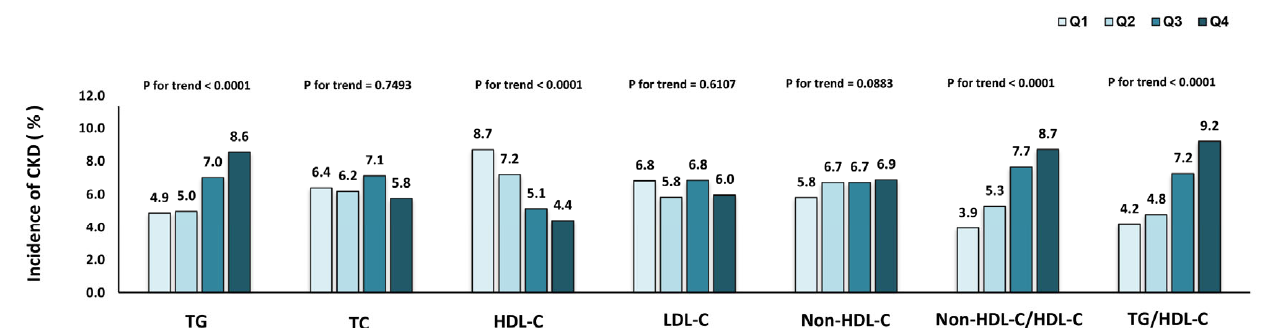
Figure 2. Incidence of chronic kidney disease in different quartiles of baseline lipid parameters. Across all Cox regression models, TG/HDL‑C showed the highest association with Table 3. Association between baseline lipid parameters and risk of CKD. CKD in comparison to other lipid parameters (Table 3). Additionally, among all AUC values, TG/HDL‑C was highest (0.599, 95% CI: 0.568–0.630). To validate the robustness of this outcome, we carried out a stratified analysis to determine the HRs of CKD per quartile gain in TG/HDL‑C in distinct subgroups. Such an association varied under the influence of different stratification factors, as shown in Figure 3. The link between TG/HDL‑C and CKD incidence was meaningful in both age strata ( ≥ 58 and <58), in the female strata, in the BMI strata (normal and overweight), in both central obesity strata, in the subjects without diabetes stratum and in the subjects without hypertension stratum. The interaction term for the correlation between TG/HDL‑C and CKD incidence by stratification factor between subgroups was not statistically